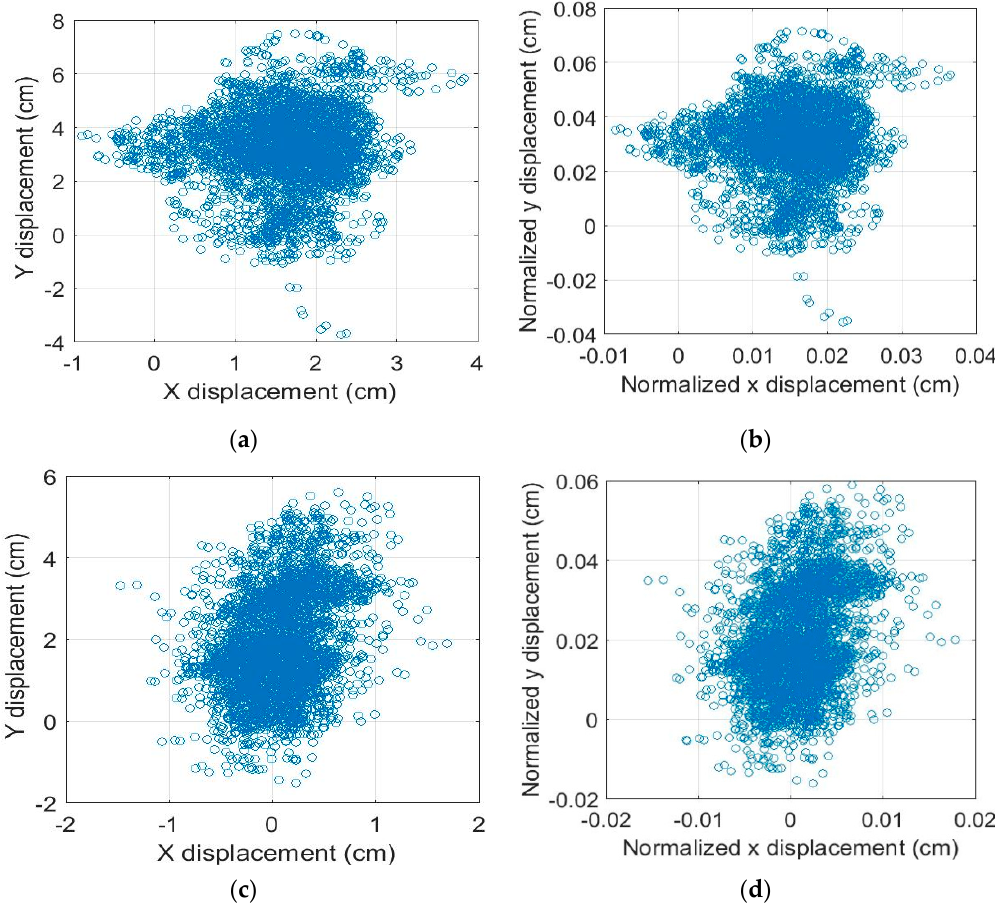
Figure 10. Accelerometry-based sway plots from two healthy adult subjects standing on a foam surface with eyes closed. ( a ) The actual COM height value was used in determining the displacements, ( b ) COM height was set to 1 to produce a normalized sway displacement plot. ( c ) and( d ) are as figures ( a ) and ( b ), but for the second subject.